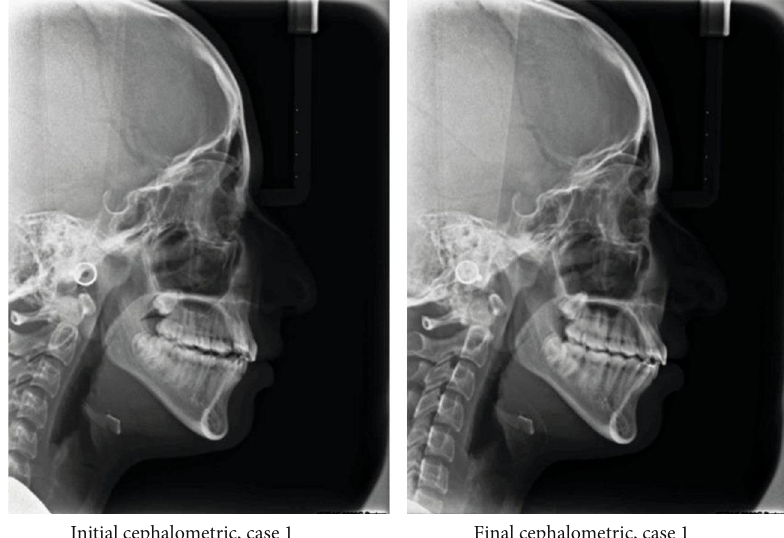
Figure 5: Initial and fi nal cephalometric radiographs.